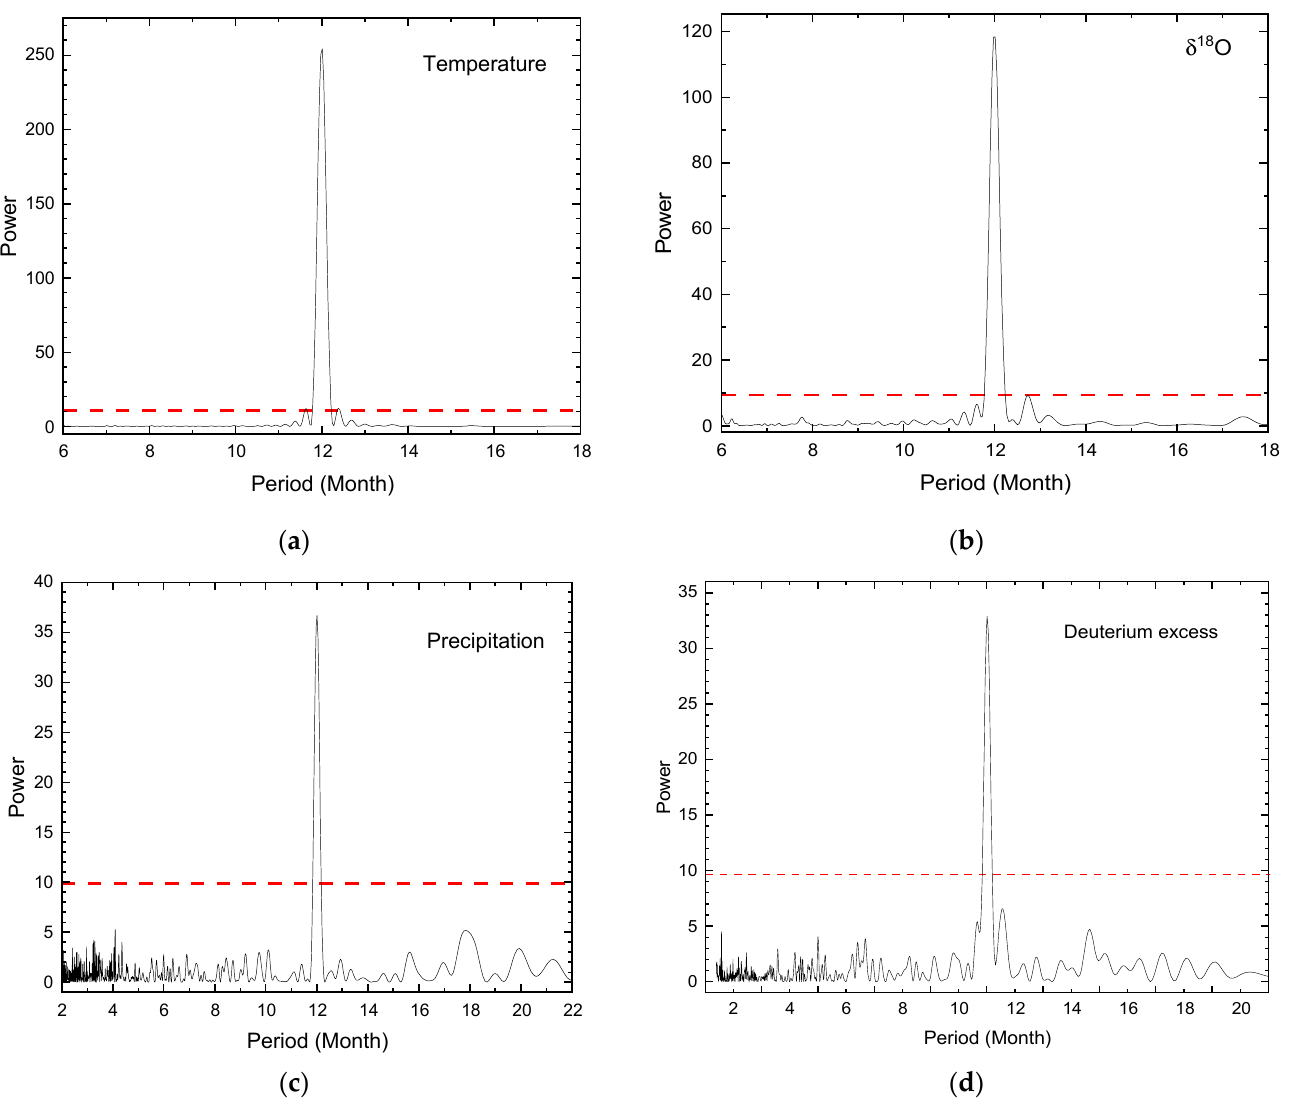
Figure 2. Fourier analysis (FA) graphs of: ( a ) temperature; ( b ) δ 18 Ο; ( c ) precipitation, and ( d ) deuterium excess. The red line marks p = 0.05 statistical significance.